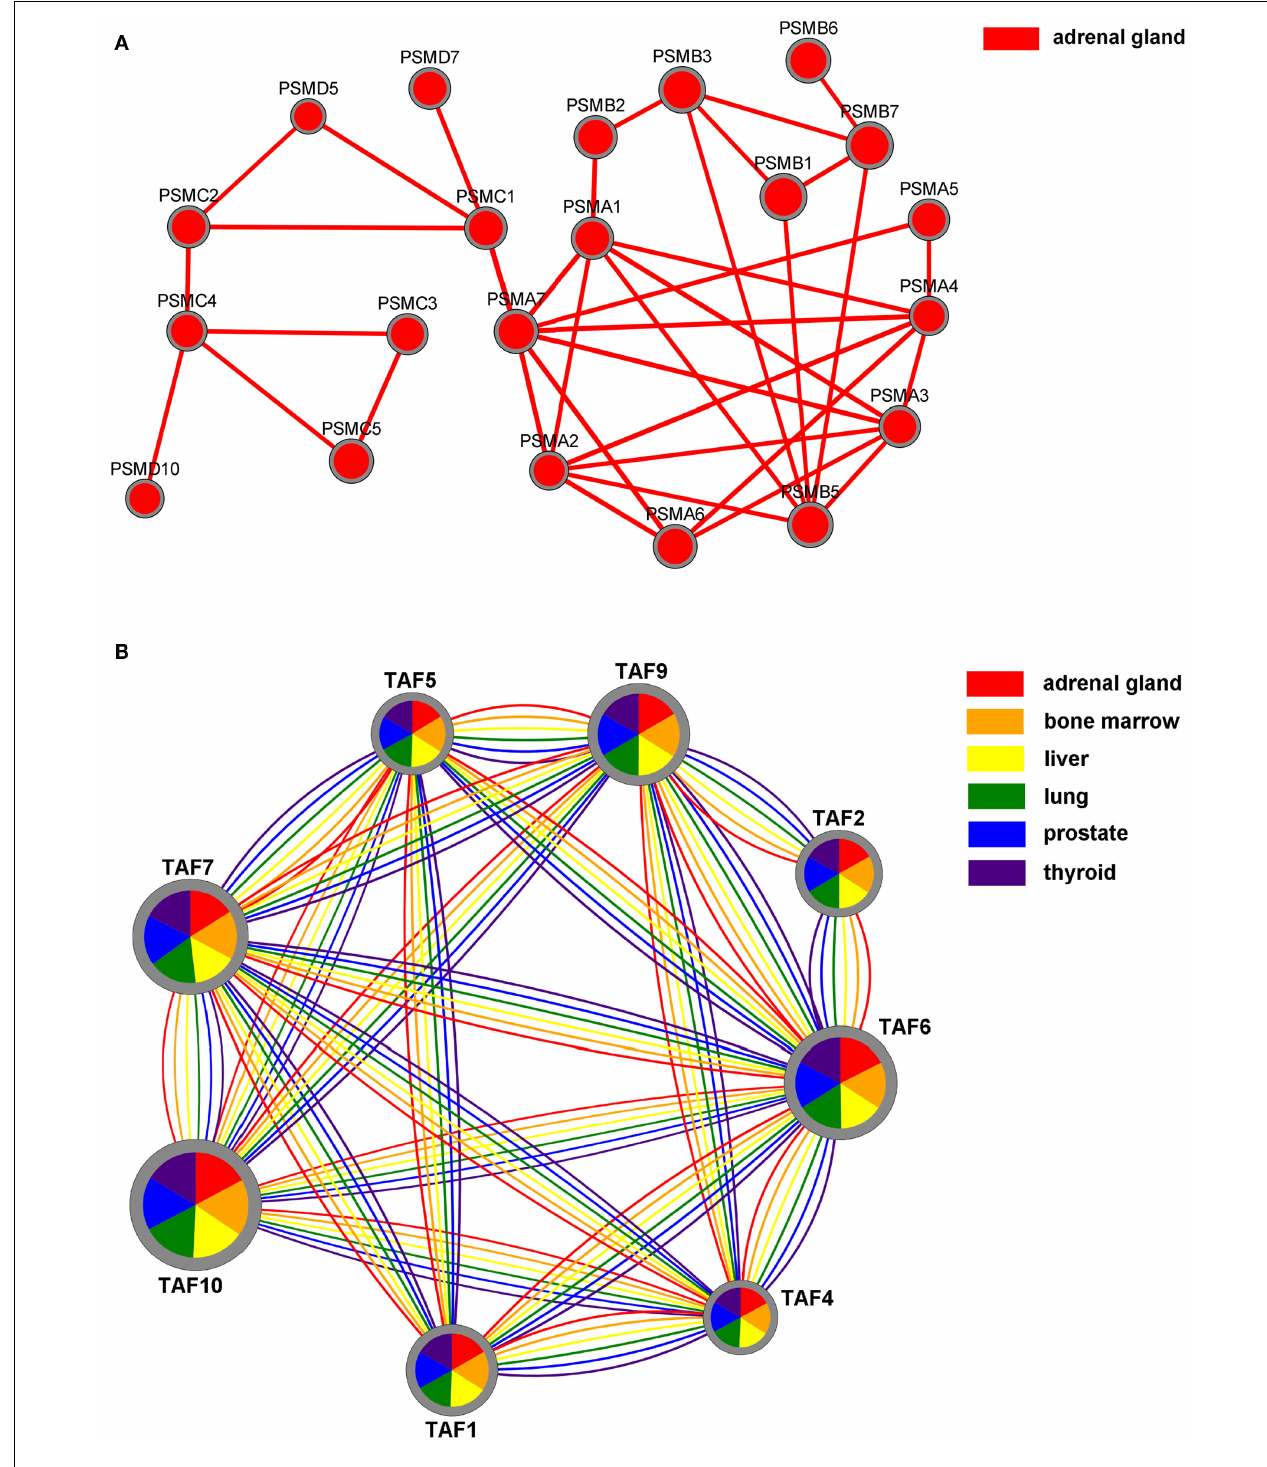
corresponding gene in a tissue. Nodes and edges are colored according to the corresponding tissue and node dimensions are proportional to the total gene expression